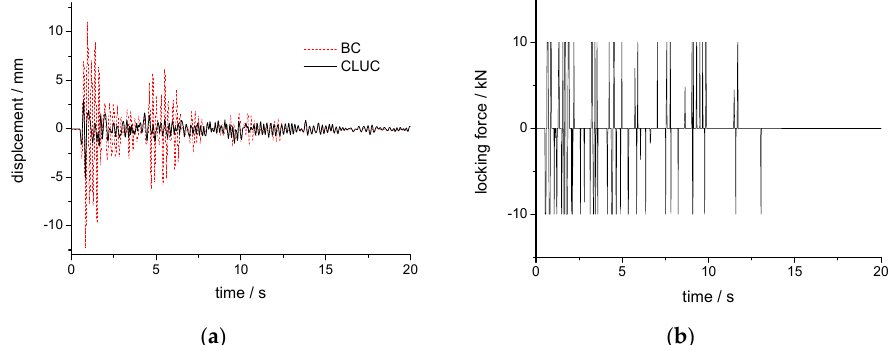
Figure 23. Time history curve: ( a ) relative displacement of side pier and girder; ( b ) output force of lock-up clutch.